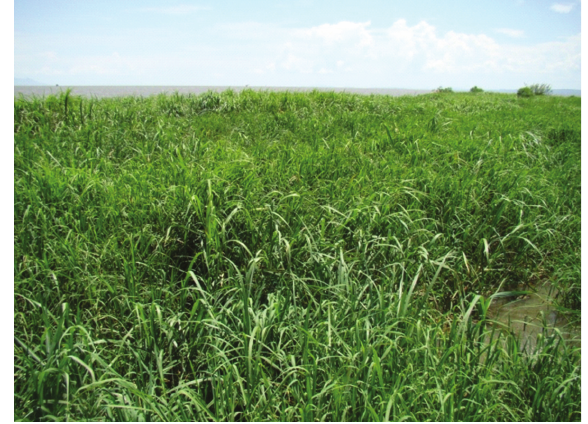
Figure 5: The climax stages of the macrophyte succession showing a single population of